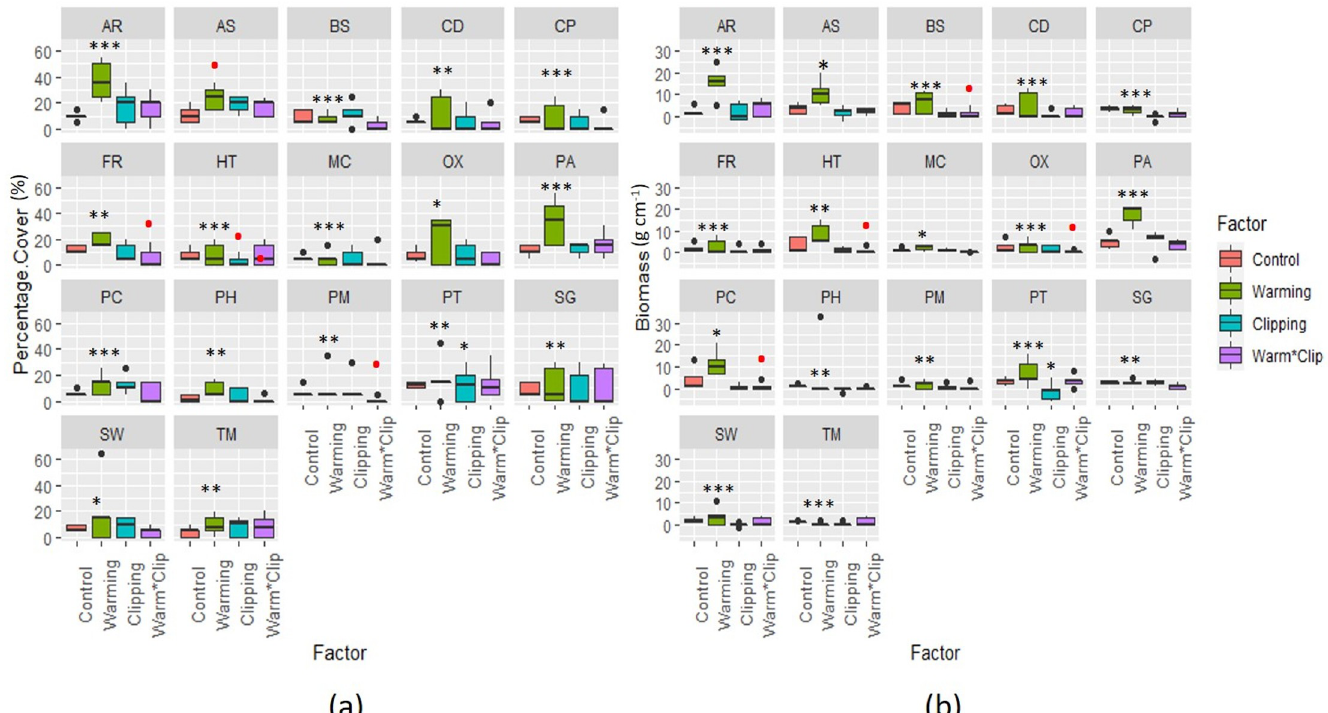
Fig 3. Species-specific responses towards each treatment. a) Data showing the percent increase in cover of each species in control, warmed, and clipped plots. b) in above ground biomass of each species in response to warming, clipping, and warming x clipping in comparison to control, warming has an overall positive effect on percentage cover and biomass of species while clipping has a negative effect. The � shows a significant response in particular species to the specific treatment while the dots are outliners. The significant codes ‘ ��� ’ 0 . 001 ‘ �� ’ 0 . 01 ‘ � ’ 0 . 05 ‘ . ’ 0 . 1 ‘ ‘ 1